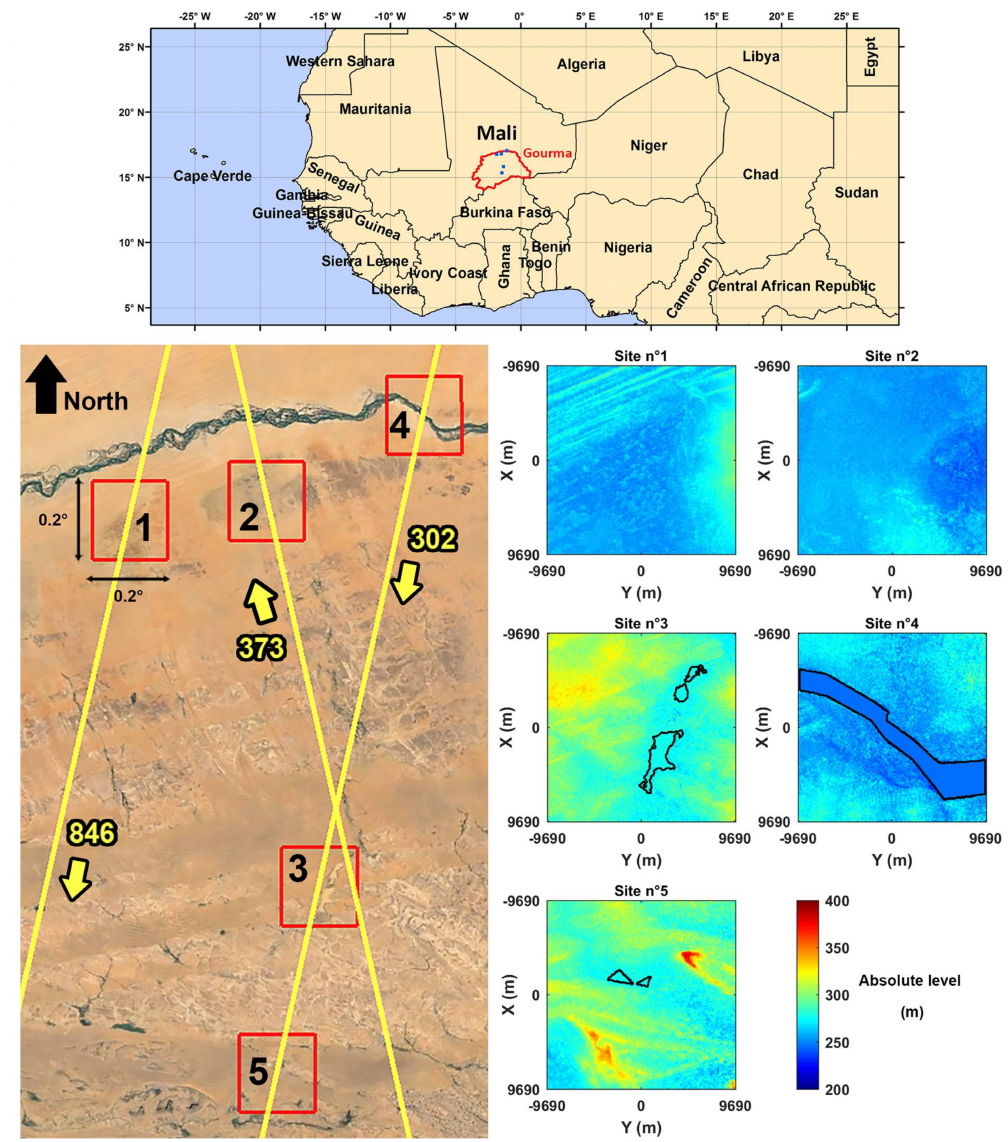
Figure 5. Location of the five study sites distributed on satellite tracks 302, 373 and 846 of ENVISAT/SARAL over the Gourma region, Mali © Google Earth. The azimuthal direction of the satellite on orbit, the site numbers and the corresponding DEM extraction area are indicated. The water areas limits over each site are marked with black